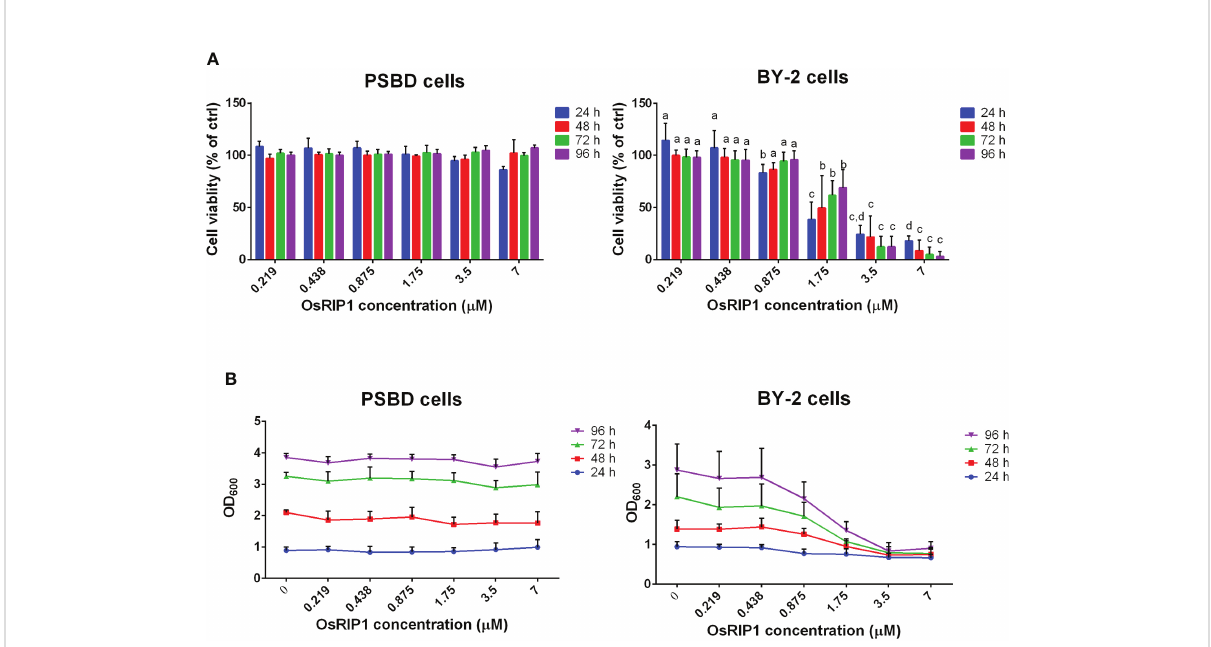
FIGURE 1 OsRIP1 dose effects on PSB-D cells and BY-2 cells. Cells were incubated in the absence or presence of various concentrations of OsRIP1 for 24 h, 48 h, 72 h and 96 h, respectively. (A) cell viability relative to control cells. (B) Optical density of cell cultures at 600 nm (OD 600 ). 1, PSB-D cells; 2, BY-2 cells. Values are the means ± SD of four independent experiments. Statistically signi fi cant differences (p < 0.05) between different concentrations of OsRIP1 treatments after incubation for the same duration (i.e., 24 h, 48 h, 72 h, or 96 h) in the graph are indicated with different letters; the same letters indicate no signi fi cant differences, with